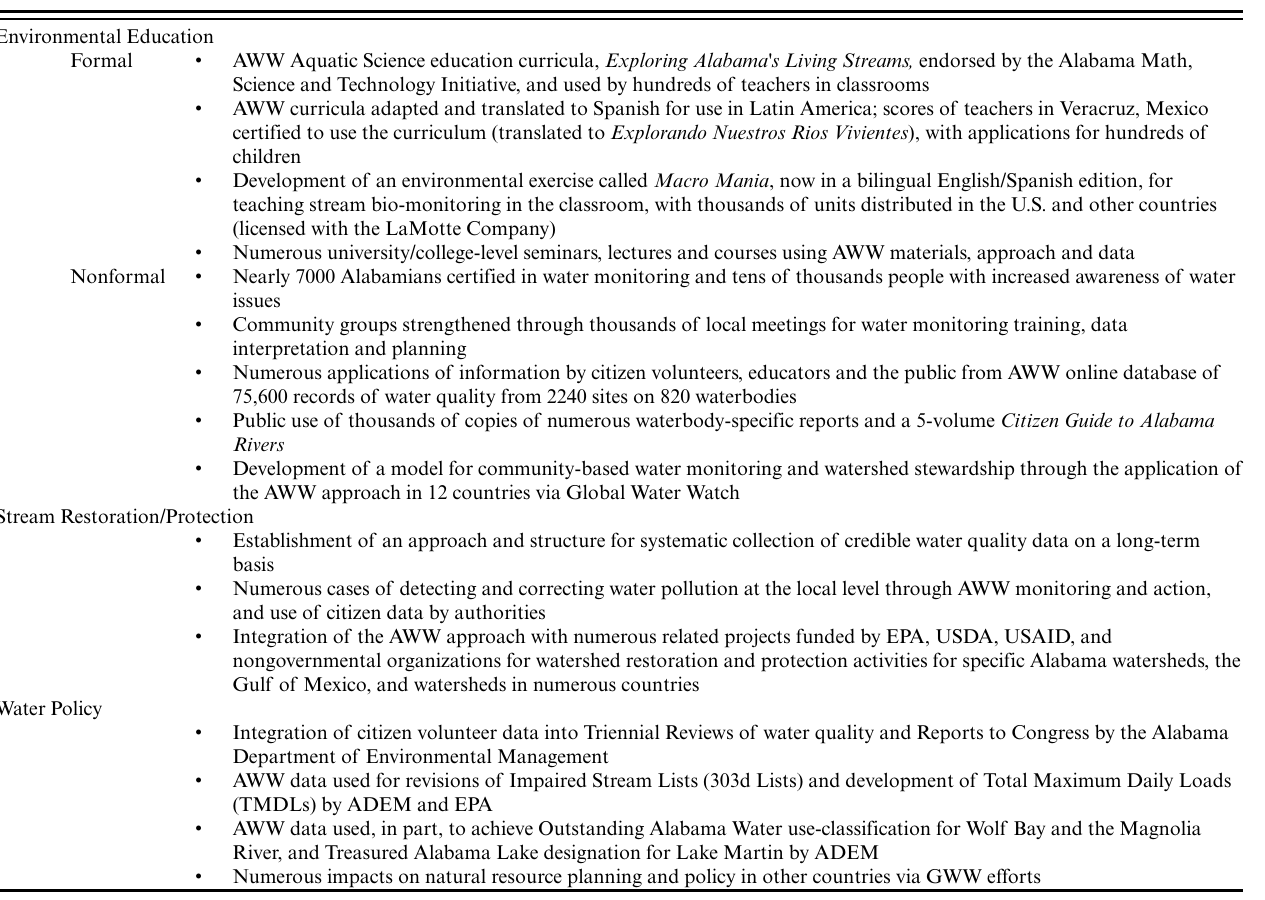
Table 3 . Impacts of Alabama Water Watch (AWW) on ecosystems and